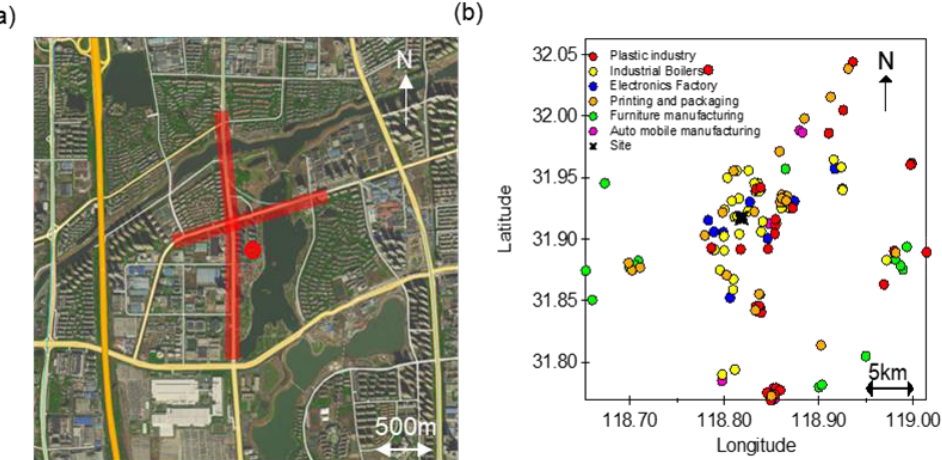
Figure 1. ( a ) Location of the sampling site (red dot) and its surroundings (red lines denote two arterial roads); ( b ) Spatial distribution of industrial plants (colored by different types) around the site (black star).